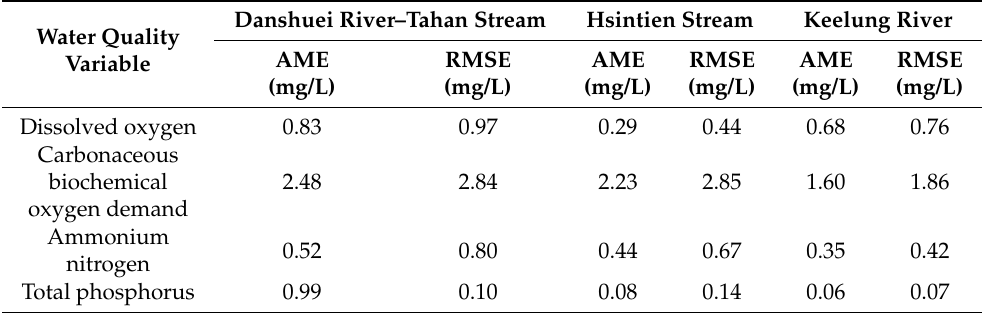
Table 4. Statistical error between simulated and measured water quality state variables on 1 June 2011. Water Quality